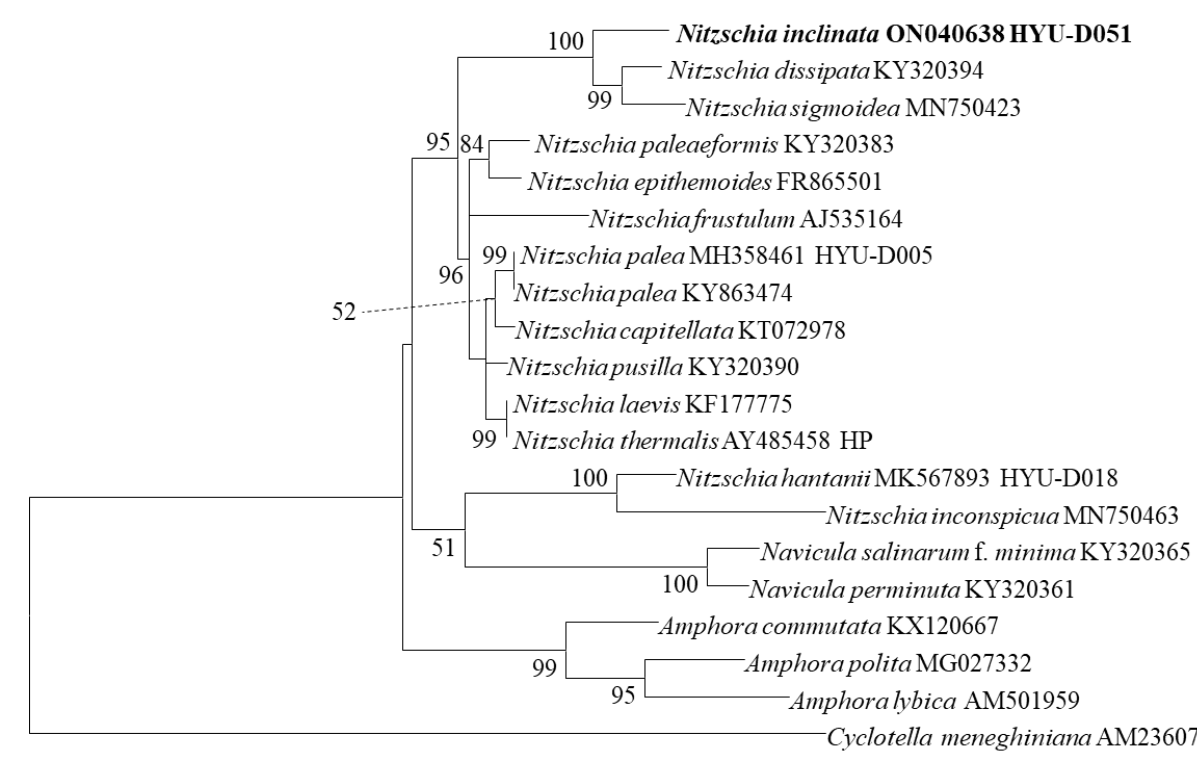
Figure 12. SSU rRNA phylogenetic tree by maximum likelihood method of Nitzschia inclinata sp. nov. and other species molecular position. The tree with the highest log likelihood ( − 4374.77) is shown. The percentages of trees in which the associated taxa clustered together are shown next to the branches. The analysis involved 20 nucleotide sequences and 1392 positions in the final data set. Cyclotella meneghiniana was used as the outgroup.